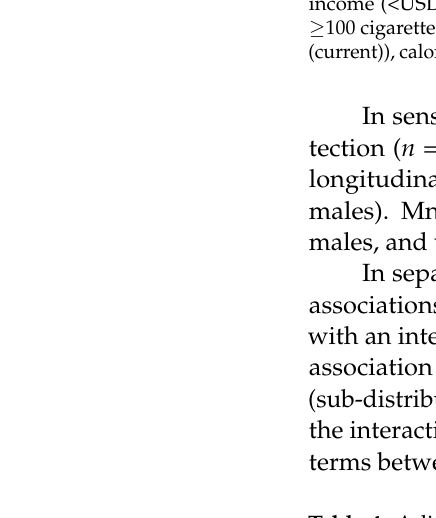
Table 4. Adjusted longitudinal associations a between quartiles of manganese and metabolic syn- drome b in models with an interaction term between manganese and quartiles of other